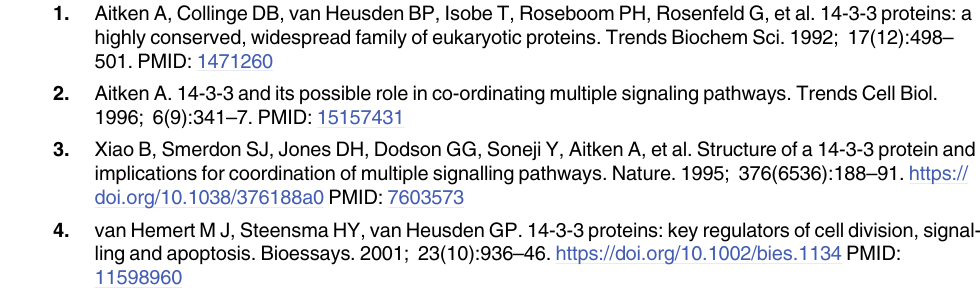
S1 Table. Summary of 14-3-3 isoform sequences. Summary of 14-3-3 gene family members present in lower eukaryotic pathogens which are retrieved from multiple data bases for sequence alignment. S2 Table. Selected list of EhP3-associated proteins. EhP3-associated proteins identified by LC-MS after immuno-pull down from E . histolytica whole cell lysate using anti-EhP3 anti-